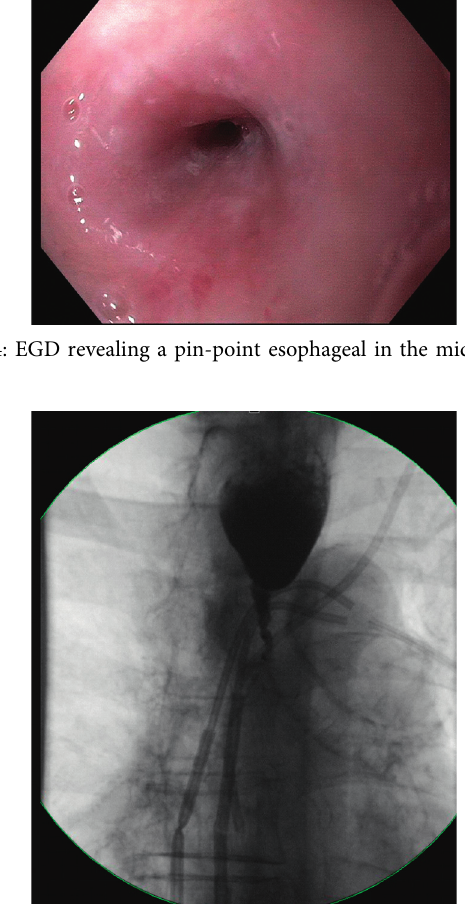
Figure 5: Barium swallow demonstrating a severe narrowing in the mid and distal esophagus with proximal dilation.